Question: Summarize what this figure shows in one sentence.
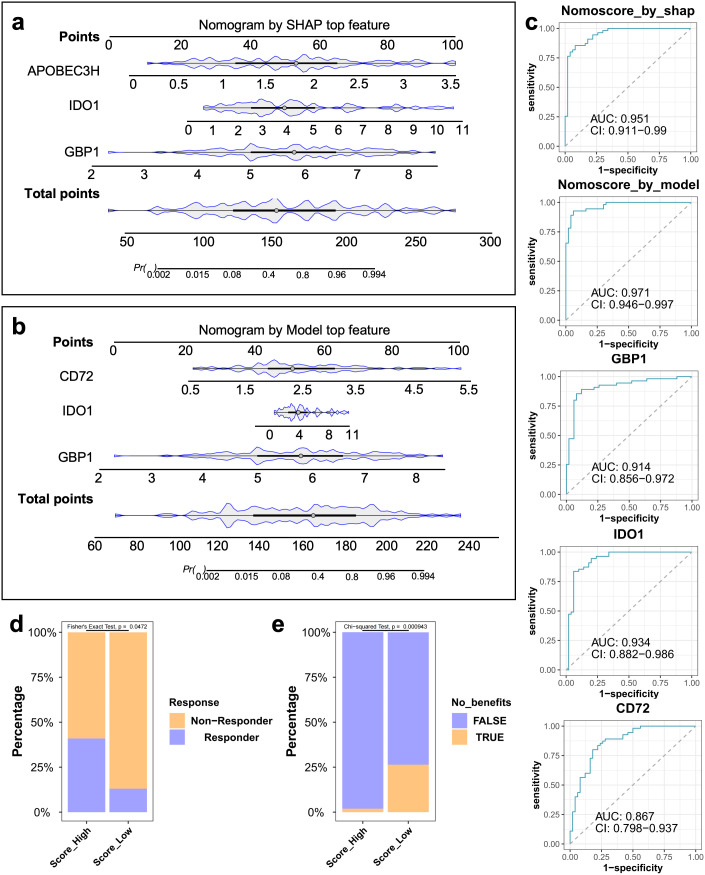
Answer: Development and validation of the clinical nomograms. This study examines (A, B) the nomograms constructed based on top features from SHAP and machine learning models, (C) the ROC curves for nomoscores and individual hub genes (GBP1, IDO1, CD72) to assess diagnostic accuracy, and (D, E) the predictive performance of the nomoscore in identifying immunotherapy responders and patients with clinical benefits. *, P < 0.05; **, P < 0.01.